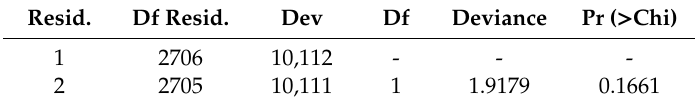
Table 21. Comparison of the variables camera rotation and contrast ratio by ANOVA.